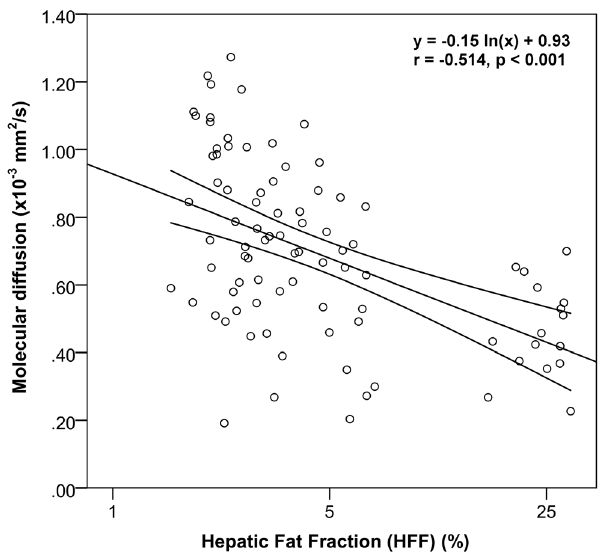
Figure 2. Regression plot between HFF and molecular diffu- sion. The correlation between HFF (%) and molecular diffusion ( 6 10 2 3 mm 2 /s) was assessed by using a log-linear model. Pearson’s product-moment correlation and its significance were calculated. The log-linear regression line is displayed together with its 95% confidence interval.